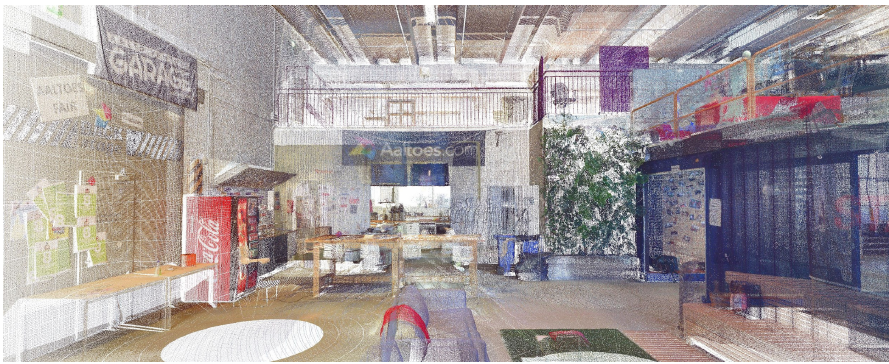
Figure 13. Snapshot of TLS point cloud from Startup Sauna.